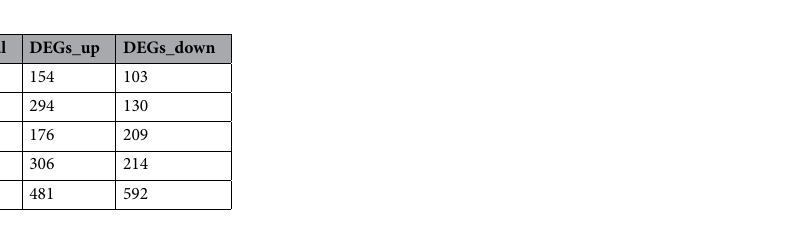
Table 3. The number of DEGs at the five time points compared to control group.